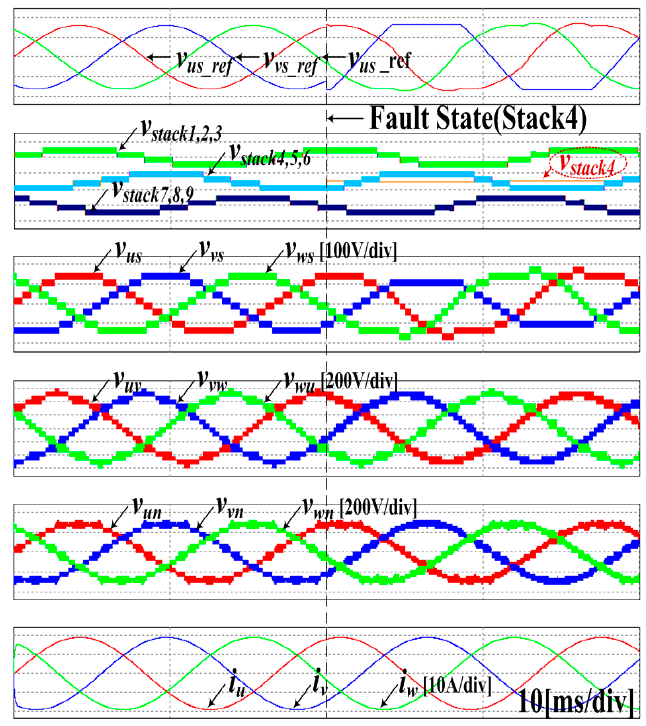
Figure 20. Simulation waveform when V phase fourth stack fails in applying the proposed neutral-point voltage-shifting control.